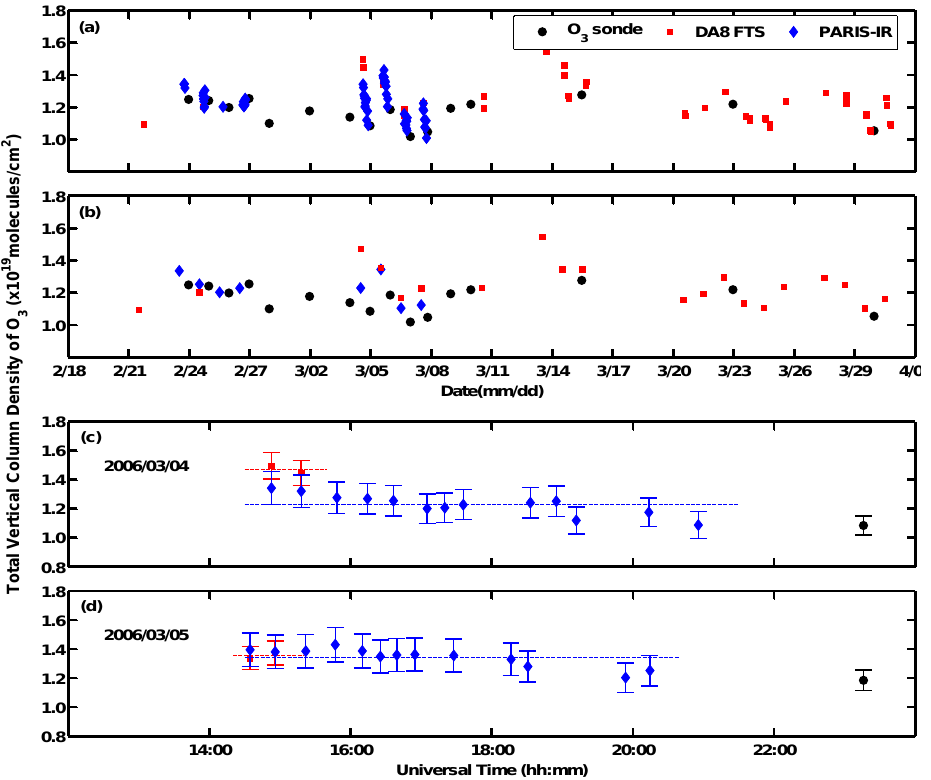
Fig. 3. O 3 total vertical column densities obtained from the spectra near MW 1120cm − 1 (MW1120) recorded using PARIS-IR (blue diamonds) and the DA8 FTS (red squares) during the 2006 Canadian Arctic ACE Validation Campaign are shown together with total columns calculated from ozonesonde measurements (black circles). Panels (a) and (b) show the individual and the daily mean column densities for the entire campaign period, respectively. Enlarged views of daily observations and uncertainties of total column densities on 4 and 5 March 2006 are shown in panels (c) and (d) , respectively. Red and blue dashed lines indicate the daily mean vertical column densities for the DA8 FTS and PARIS-IR, respectively. The errors for DA8 and PARIS-IR are the total percent errors given in Table 3. For the measurements using ozonesondes, the total columns were estimated by extrapolating above the highest measured altitude and the uncertainty given is ± 6% (taken from Tarasick et al.,